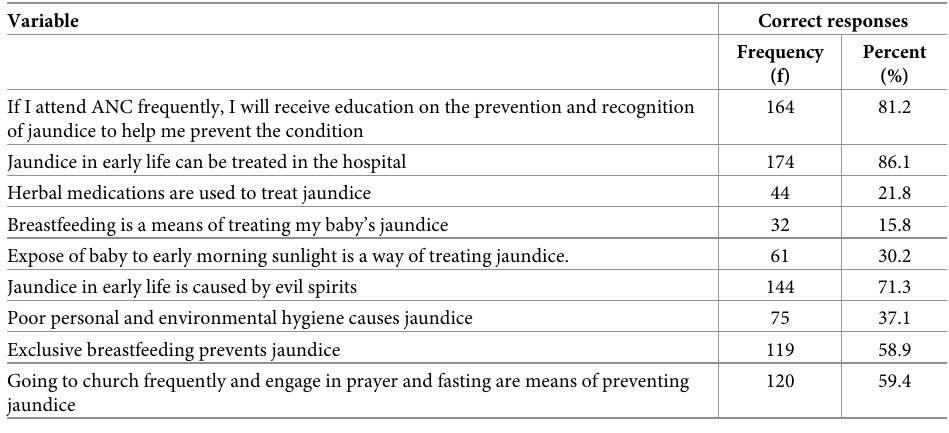
Table 3. Attitude of caregivers towards neonatal jaundice.